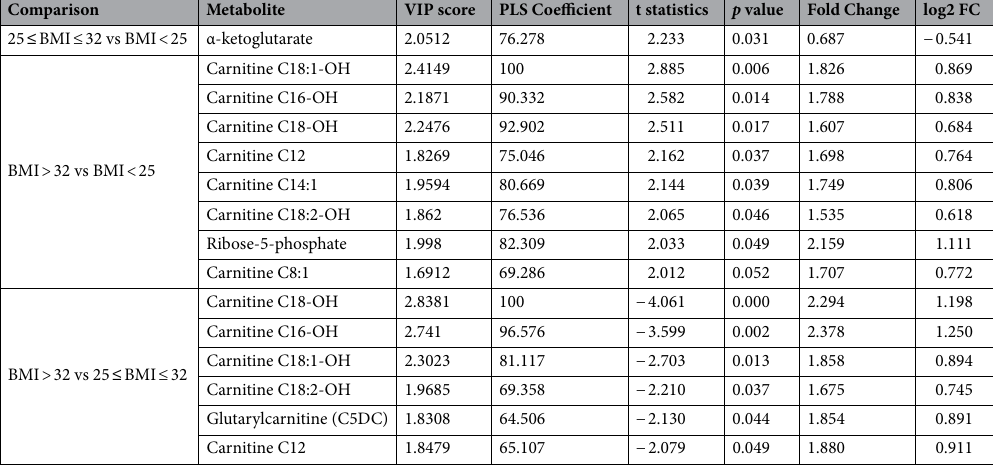
Table 2. Differentially expressed metabolites between analyzed groups. Positive log2 fold change (log2 FC) indicates higher expression in the group with the higher BMI. VIP score, Variable Importance in Projection in the Partial Least Square Discriminant Analysis; PLS Coefficient, regression parameters in the Partial Least Square